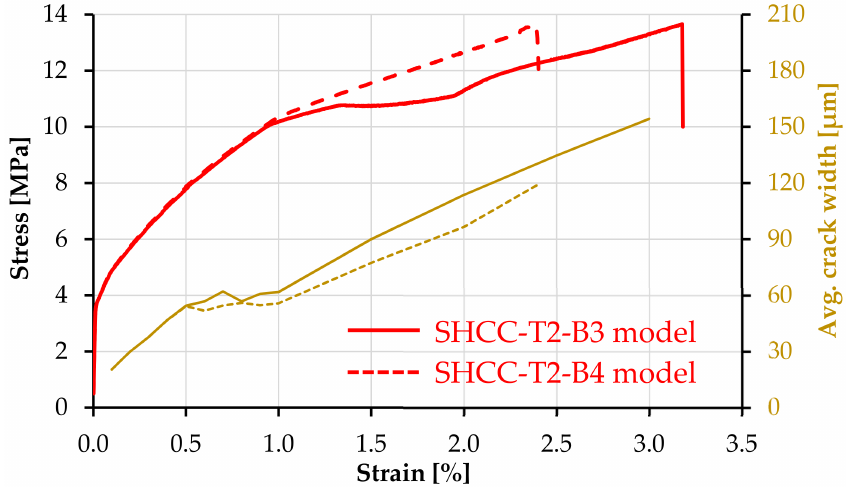
Figure 16. Macroscopic stress–strain curves and average crack widths of the SHCC-T2-B3 (continu- ous) and SHCC-T2-B4 (dashed) model